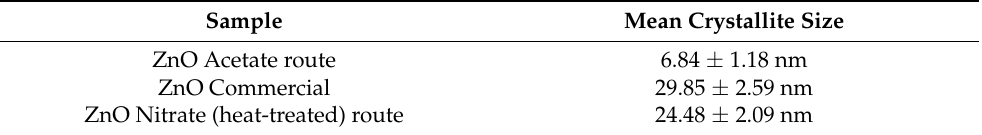
Table 1. Mean crystallite size obtained from the Scherrer equation applied to the first seven crystallo- graphic peaks of investigated samples.